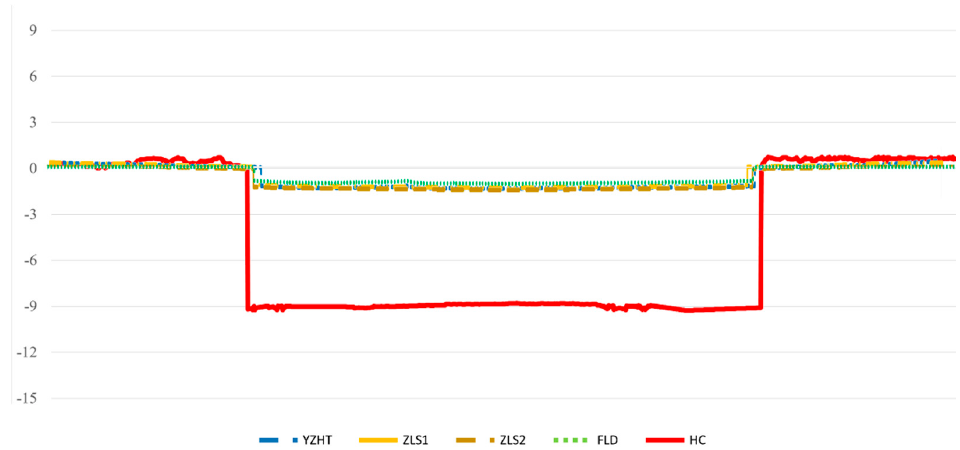
Figure 6. Surface profiles of representative specimens from according to the ceramic material (YZHT, FDL, ZLS1, ZLS2 and HC) after 15 years of toothbrushing simulation. Table 2. Two-way ANOVA of abrasive wear according to the factors: ceramic material and time.